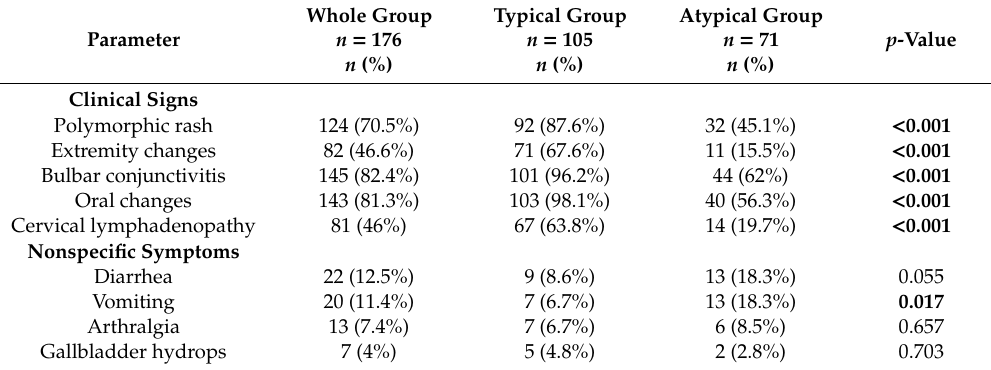
Table 2. Clinical characteristics in typical and atypical KD patients.